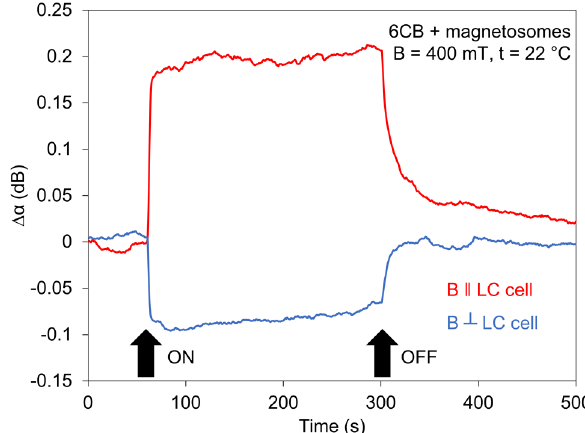
Figure 10. Effect of jumped magnetic field (400 mT) on SAW attenuation of 6CB doped with magne- tosomes (0.2 wt%) at two different magnetic field orientations, B ⊥ LC cell, and B ∥ LC cell.